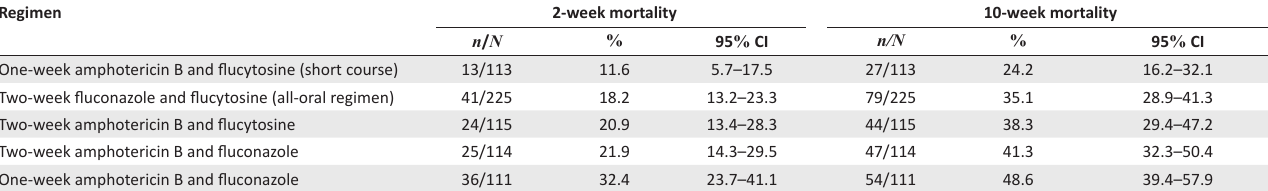
TABLE 4: Unadjusted 2- and 10-week mortality outcomes for the five combination treatment regimens in the Advancing Cryptococcal Treatment in Africa trial. Regimen